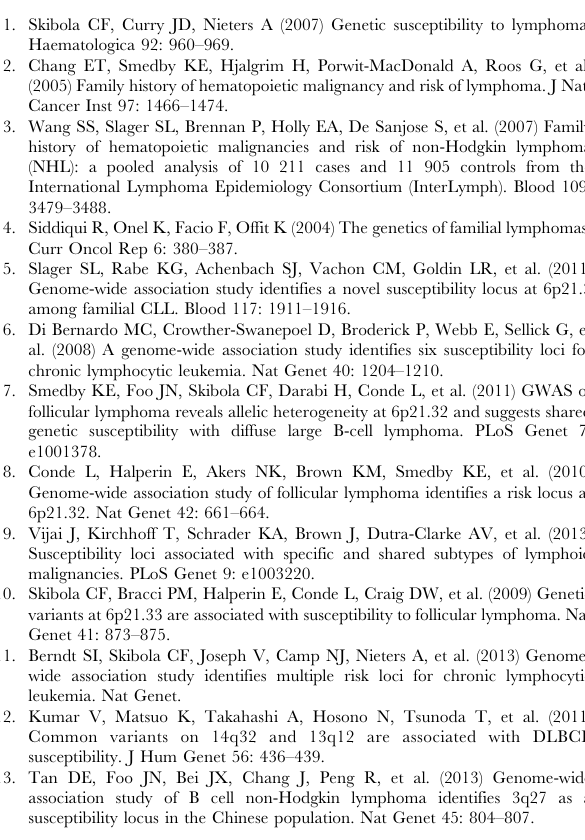
Table S1 Summary of the demographic characteristics of the case/control study population. (XLSX) Table S2 List of DNA repair genes and tagging SNPs genotyped. Chromosome and base pair position are based on GRCh37/hg19 build. Allele frequencies calculated among our sample population. (XLSX) Table S3 Results of single SNP associations analysis of tSNPs in DNA repair genes with the risk of NHL observed in our study, including 109 SNPs genotyped in stage 1 and stage 2. (XLSX) Table S4 Full list of haplotype associations (p , 0.05) for DNA repair genes associated with NHL in our study. (XLSX) Table S5 Stratified AJ and non-AJ results for SNPs associated with NHL in the main effect aggregate analysis. (XLSX) Table S6 Results from pairwise SNP-SNP interaction associations of tSNPs in DNA repair genes with NHL risk. A) Pairwise comparisons among the 15 tSNPs associated with NHL risk in the aggregate main effect analysis. B) Pairwise comparisons of 15 tSNPs with all additional SNPs genotyped in